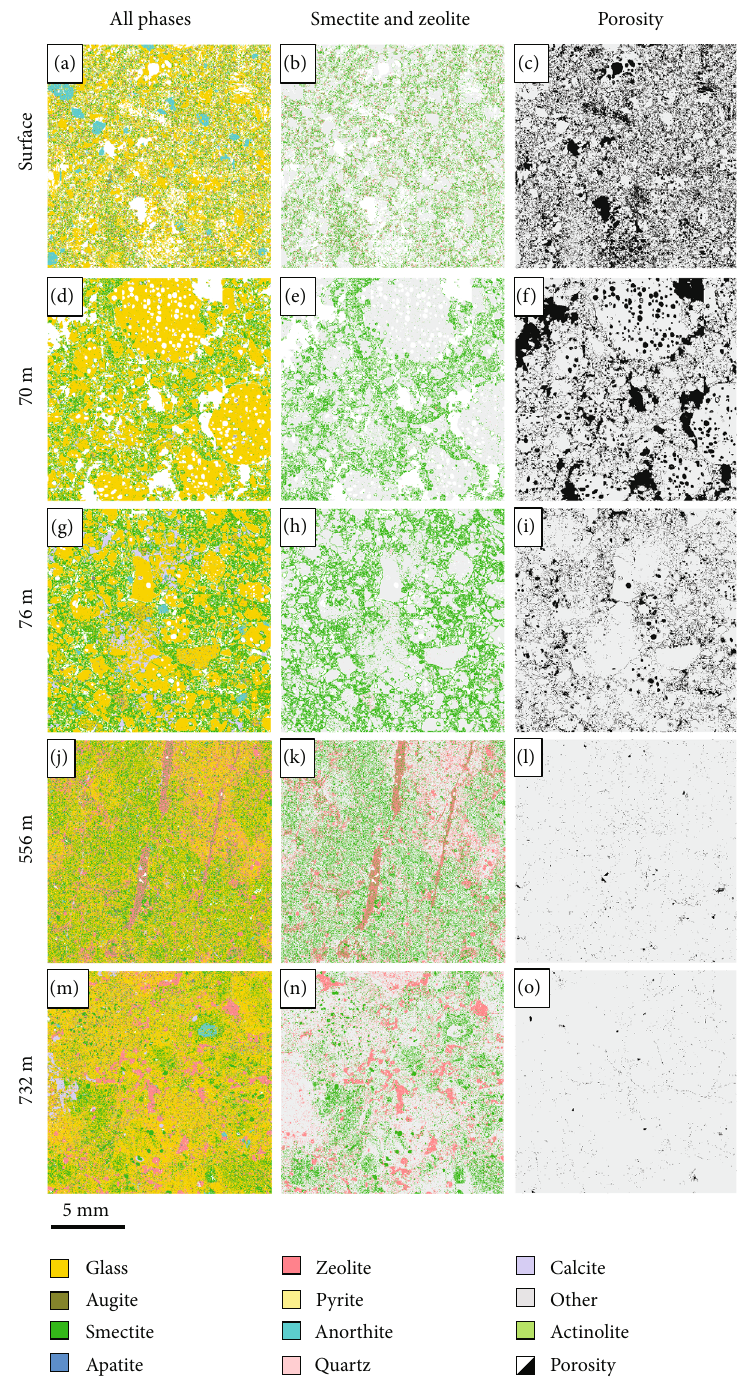
Figure 3: Colour-coded phase distribution maps of hyaloclastite from di ff erent depths within the hydrothermal reservoir at Kra fl a volcano, NE Iceland. Maps, produced by SEM-EDS QEMSCAN® (Quantitative Evaluation of Minerals by SCANning electron microscopy) with 20 µm step size, show distribution of all identi fi ed phases with porosity in white (left), smectite and zeolite with other solids in grey and porosity in white (centre), and pore space in black with all solid phases in grey (right). (a – c) The surface sample is predominantly glassy vesicular clasts in a porous matrix hosting smectite and zeolites. (d – f) The sample from 70 m depth has larger, subrounded glassy clasts in a heterogeneously distributed, porous, smectite-hosting matrix. (g – i) The sample from 76 m has smaller clasts and pores, a smectite-dominated matrix, and areas of calcite that in fi ll porosity. (j – l) The denser sample from 556 m has poorly de fi ned clasts and negligible porosity, with heterogeneously distributed smectite and zeolite throughout the clasts and matrix, with veins of dominantly zeolite and minor calcite. (m – o) The dense sample from 732m shows traces of glassy clasts, with de fi ned patches of zeolite enrichment and distributed smectite within the matrix. Some areas contain patches of calcite, which appears to in fi ll pore